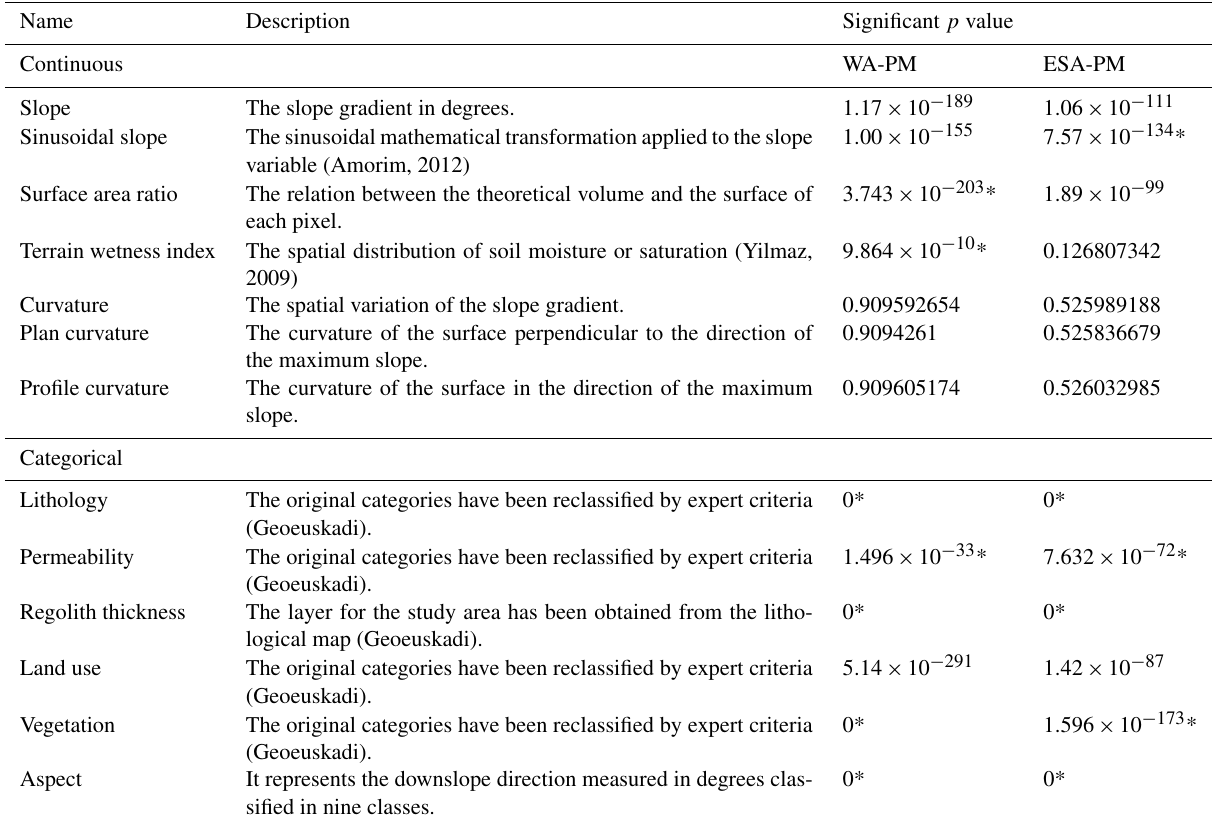
Table 2. Set of environmental variables introduced for the whole-area pixel-based (WA-PM) and effective surveyed-area pixel-based (ESA- PM) model calculation, together with the significant p -value estimate corresponding to each explanatory variable (cf. Sect. 4.1). The best predictors were labelled with an